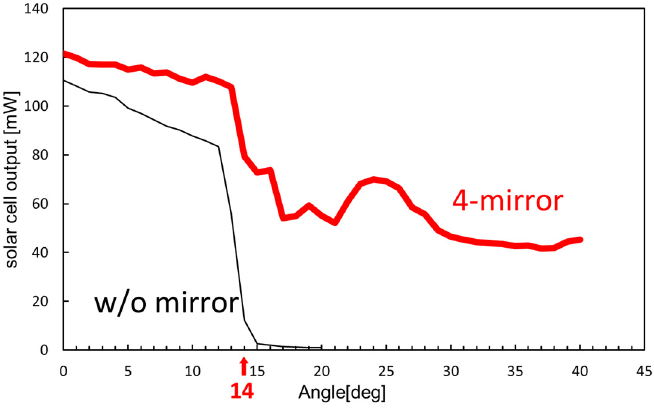
Figure 11. Experimental result of angular dependence of the light ‐ receiving module with mirrors.